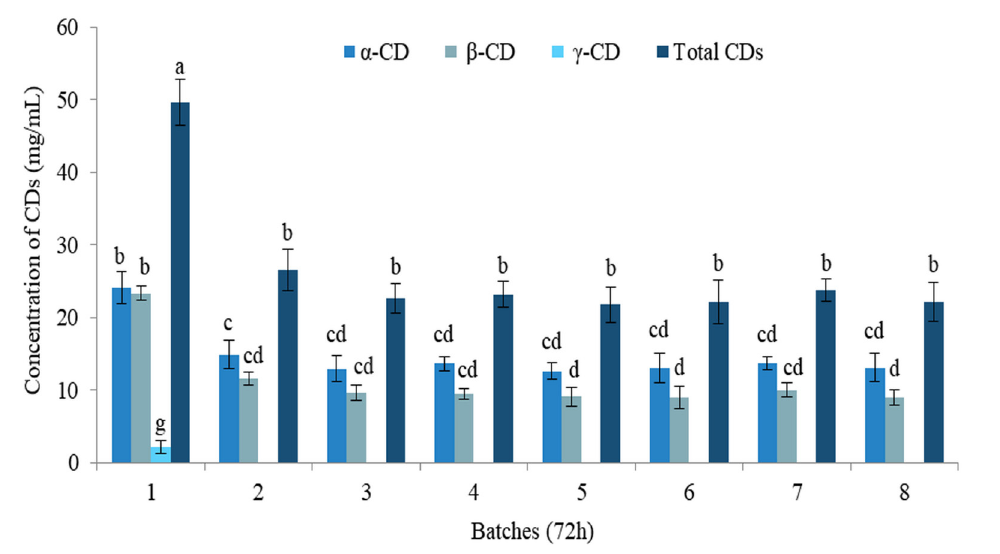
FIGURE 6 - Production of cyclodextrins in repetitive batches and ultrafiltration using 10% cassava starch with 10% ethanol and commercial enzyme 0.02% (V/V). Chromatographic